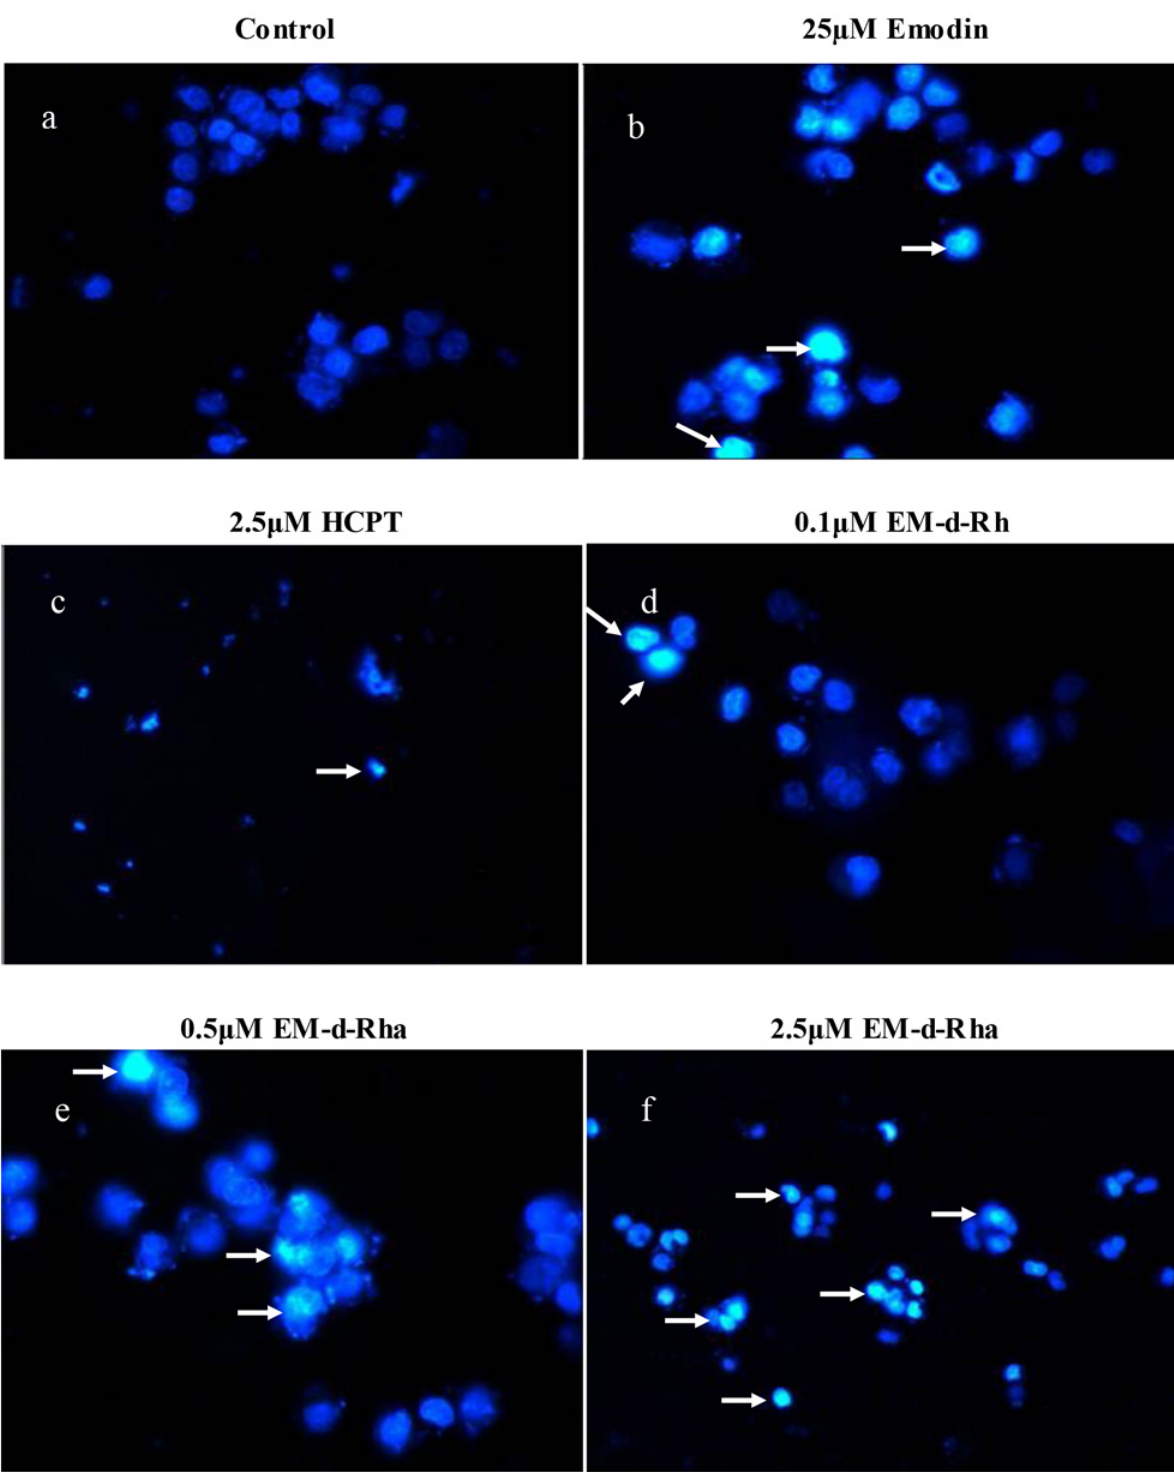
Fig 5. Fluorescence microscopic appearance of Hoechst 33342-stained nuclei of HepG2 cancer cell treated. The nuclei morphological changes of HepG2 cell were observed with fluorescence microscopy after incubated with 25.0 μ M emodin, 2.5 μ M HCPT for 48 h and with EM-d-Rha for 48 h at varying concentrations: 0 μ M (control); 0.1 μ M; 0.5 μ M; 2.5 μ M (original magnification 400×). The condensed and fragmented fluorescent nuclei (white arrows) of apoptotic cells are visible in the treated cells, but not in the control cells.